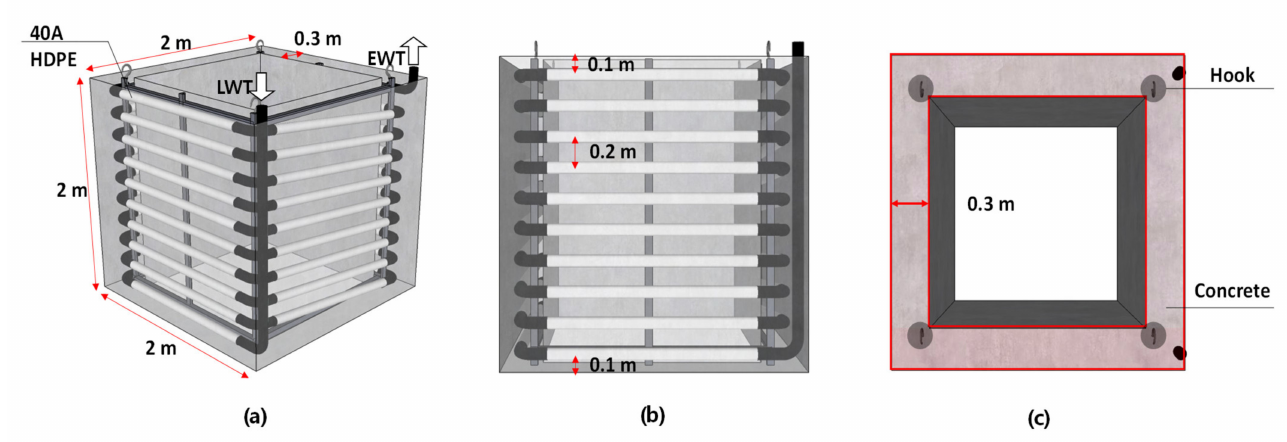
Figure 3. Configuration of Modular GHX: ( a ) 3D view; ( b ) Front view; ( c ) Top